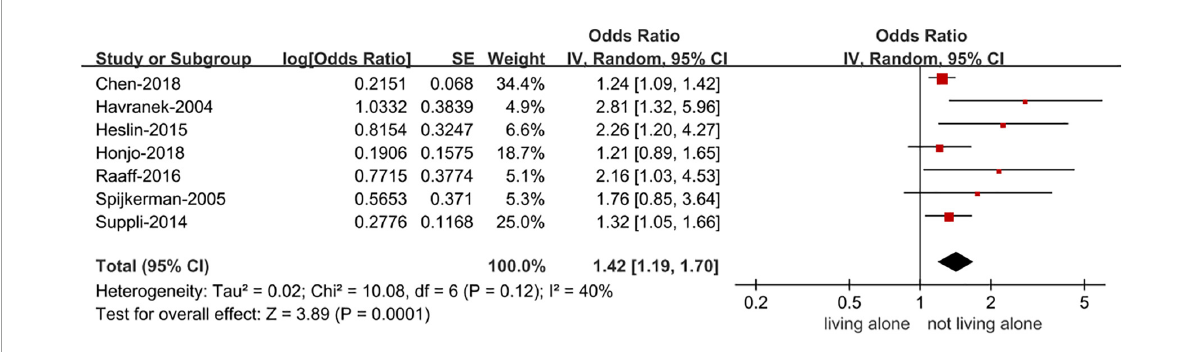
FIGURE1 Forest plot for the association of living alone with the risk of depression. CI, confidence interval; SE, standard error; IV, inverse of the